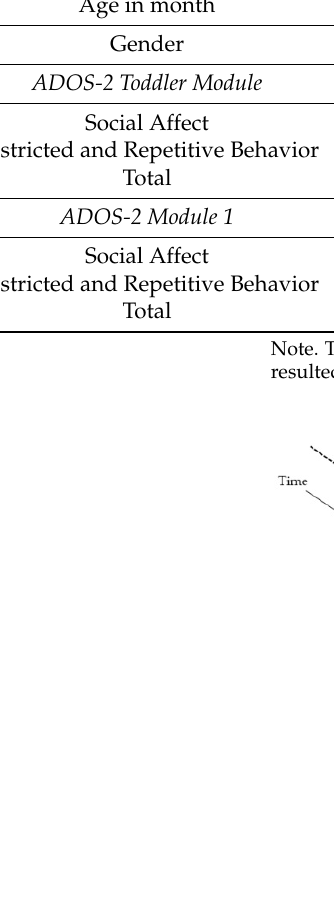
Figure 1. Illustration of the paradigm employed in the experiment.